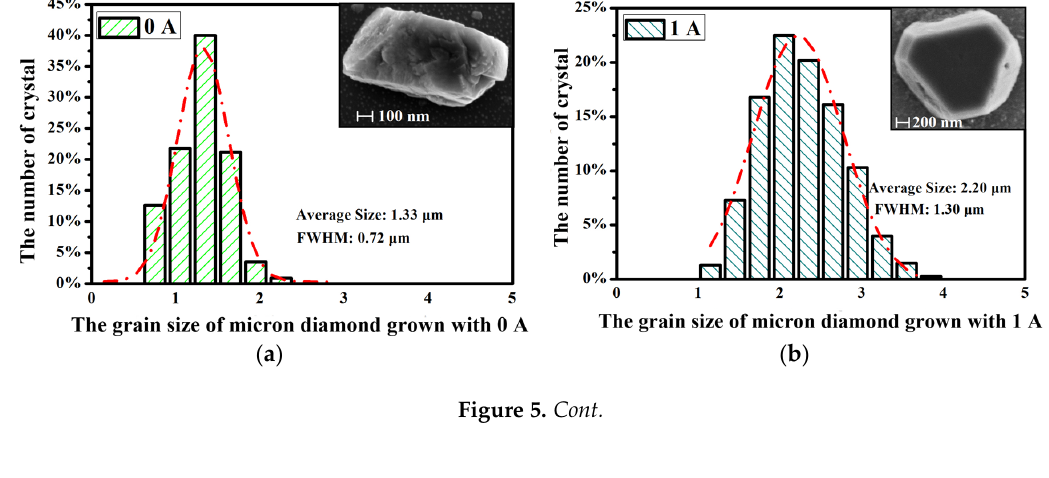
Figure 5. Cont . Figure 5.